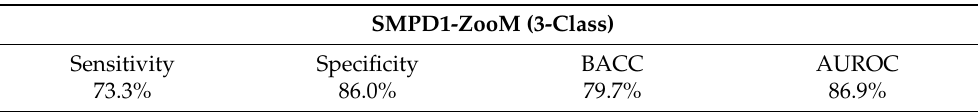
Table 2. Scores in leave-one-out cross validation of the SMPD1-specific variant classifier SMPD1- ZooM on three classes (neutral, NPDA- and